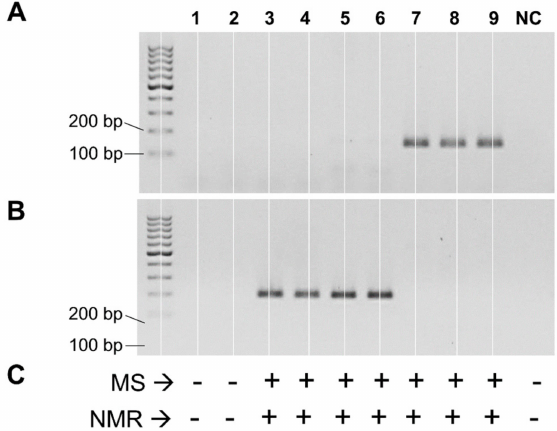
Figure 1. Detection of the choline-utilization activity in pure bacterial cultures. Panels ( A , B ) represent agarose gel resulting from end-point PCR with primers cut-Dd ( A ) and cut-Kp ( B ). Panel ( C ) summarizes the detection of TMA in cell-free broth by mass spectrometry (MS) and nuclear magnetic resonance (NMR); + , TMA detected; -, TMA not detected. Lanes: 1 , Escherichia coli 3.1; 2 , Lactococcus